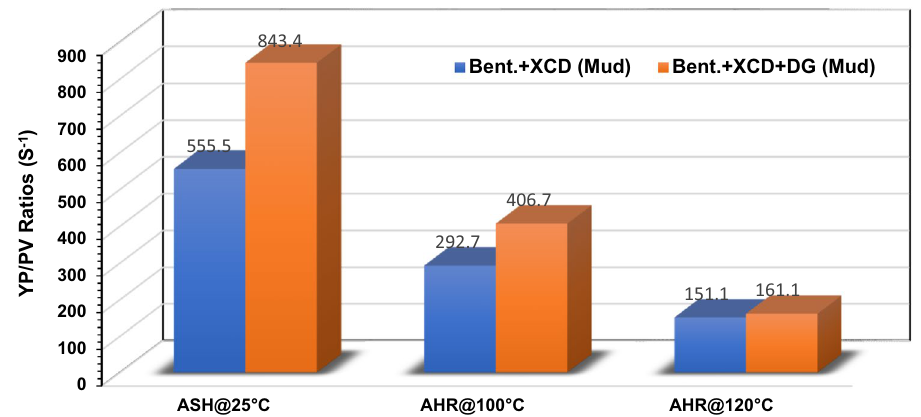
Fig. 9 YP/PV ratios of the mud